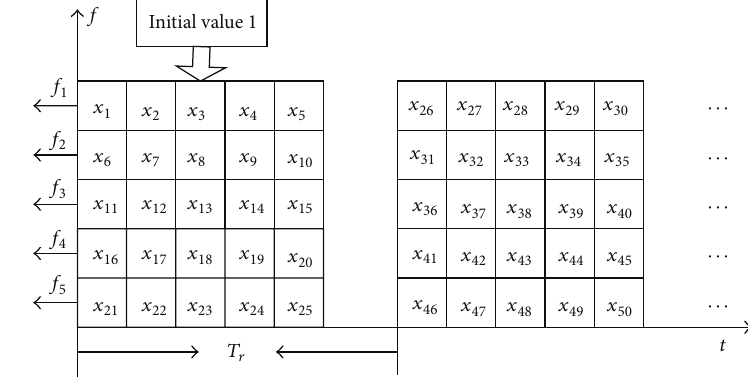
Figure 2: Structure of Chaos NNS MCPC I pulse train.